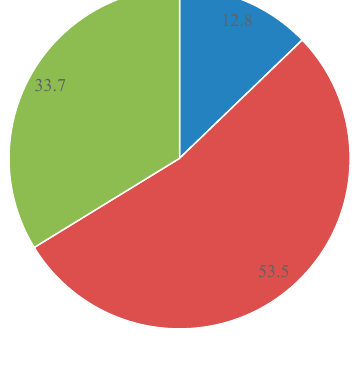
Figure 6. Water use distribution inside the household in %.